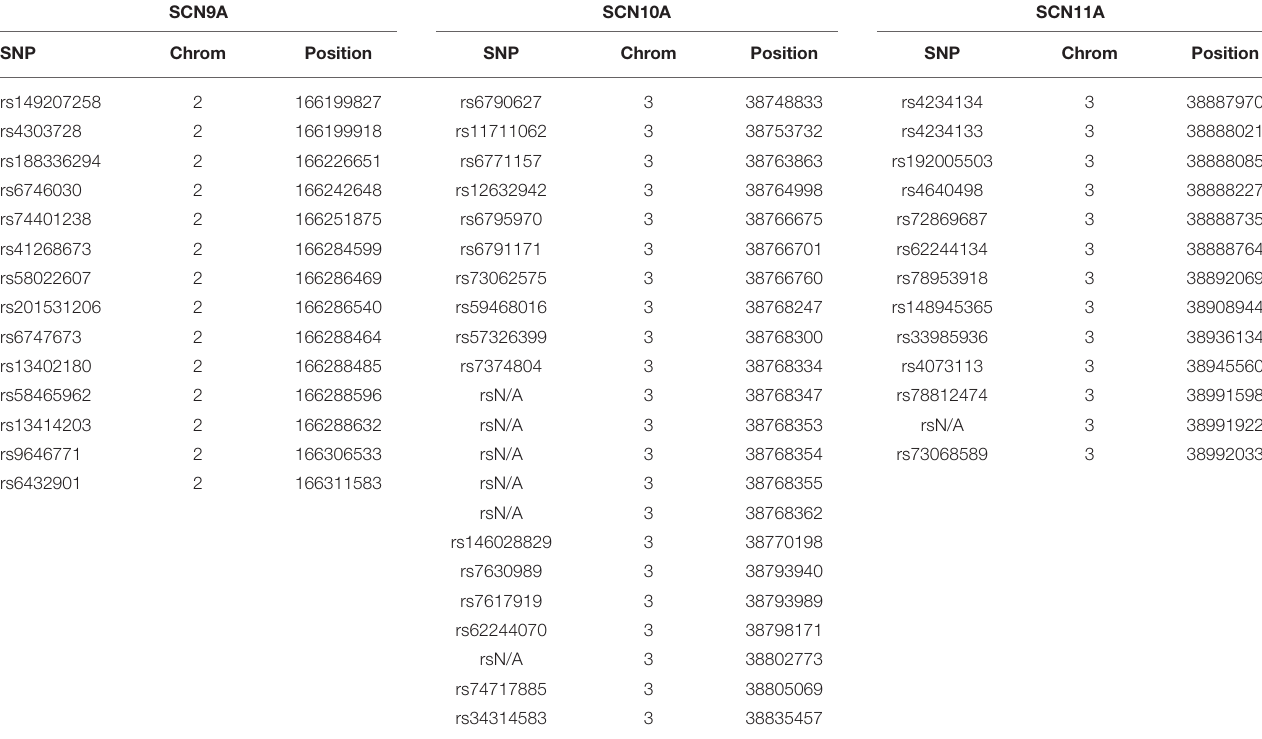
TABLE 2 | Single nucleotide polymorphisms (SNPs) identified for the SCN9A, SCN10A, and SCN11A genes in our initial study